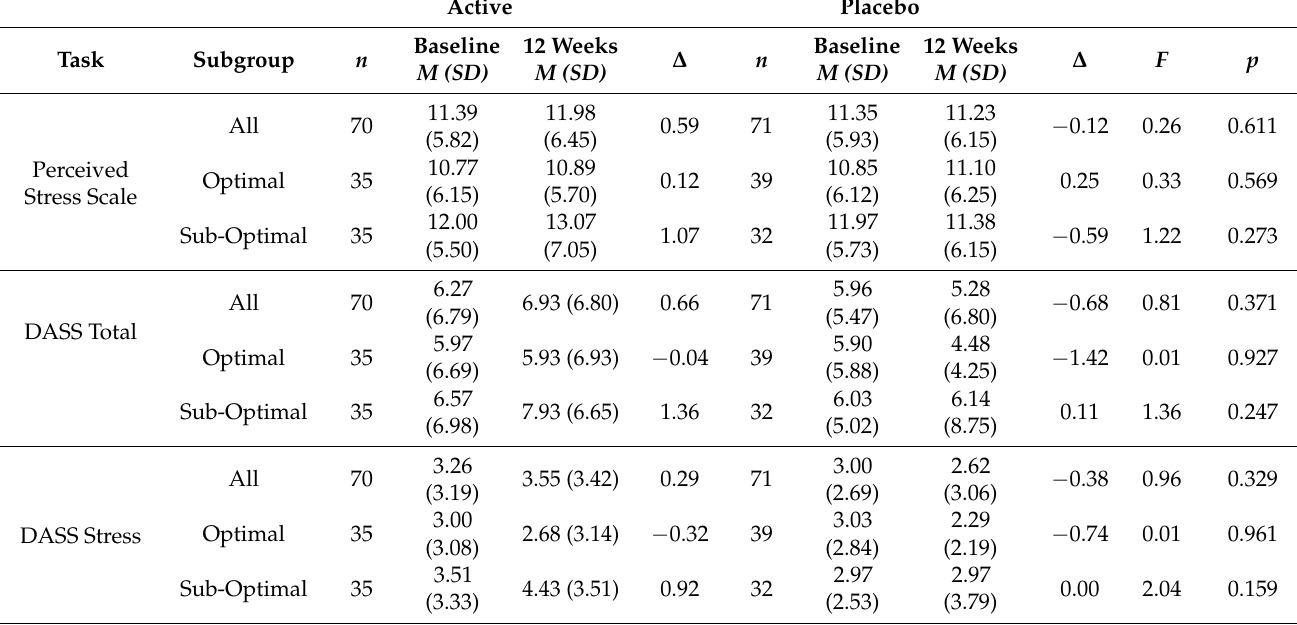
Table 3. Means, standard deviations, F value for treatment by time interaction and significance values from MMRMA analysis for mood outcomes at baseline and 12 weeks for active and placebo